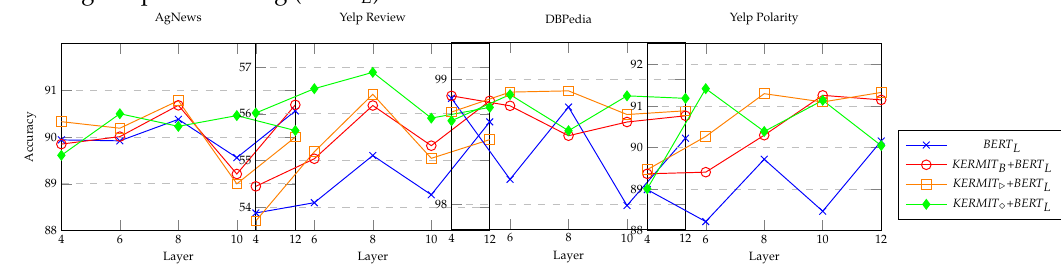
Figure 2. Comparison between KERMIT ./ Transformers and BERT when training layers in BERT B : Accuracy vs. Learned Layers in two different learning configurations—1-Epoch and 5-Epoch training Setting: 1 Epoch learning ( BERT L )